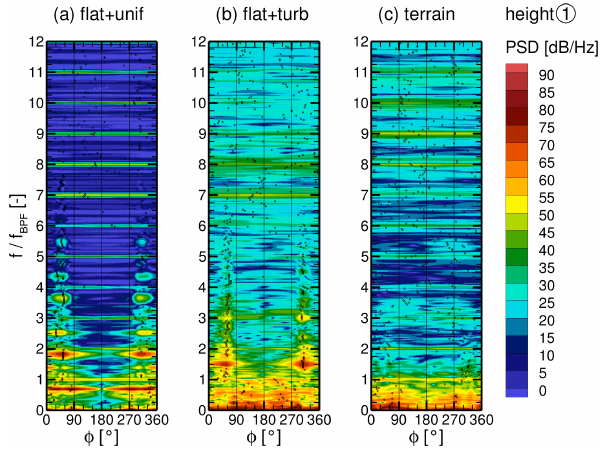
Figure 14. Power spectral density of surface pressure fluctuations on a line around the tower at height (1) for all cases (a) – (c) .